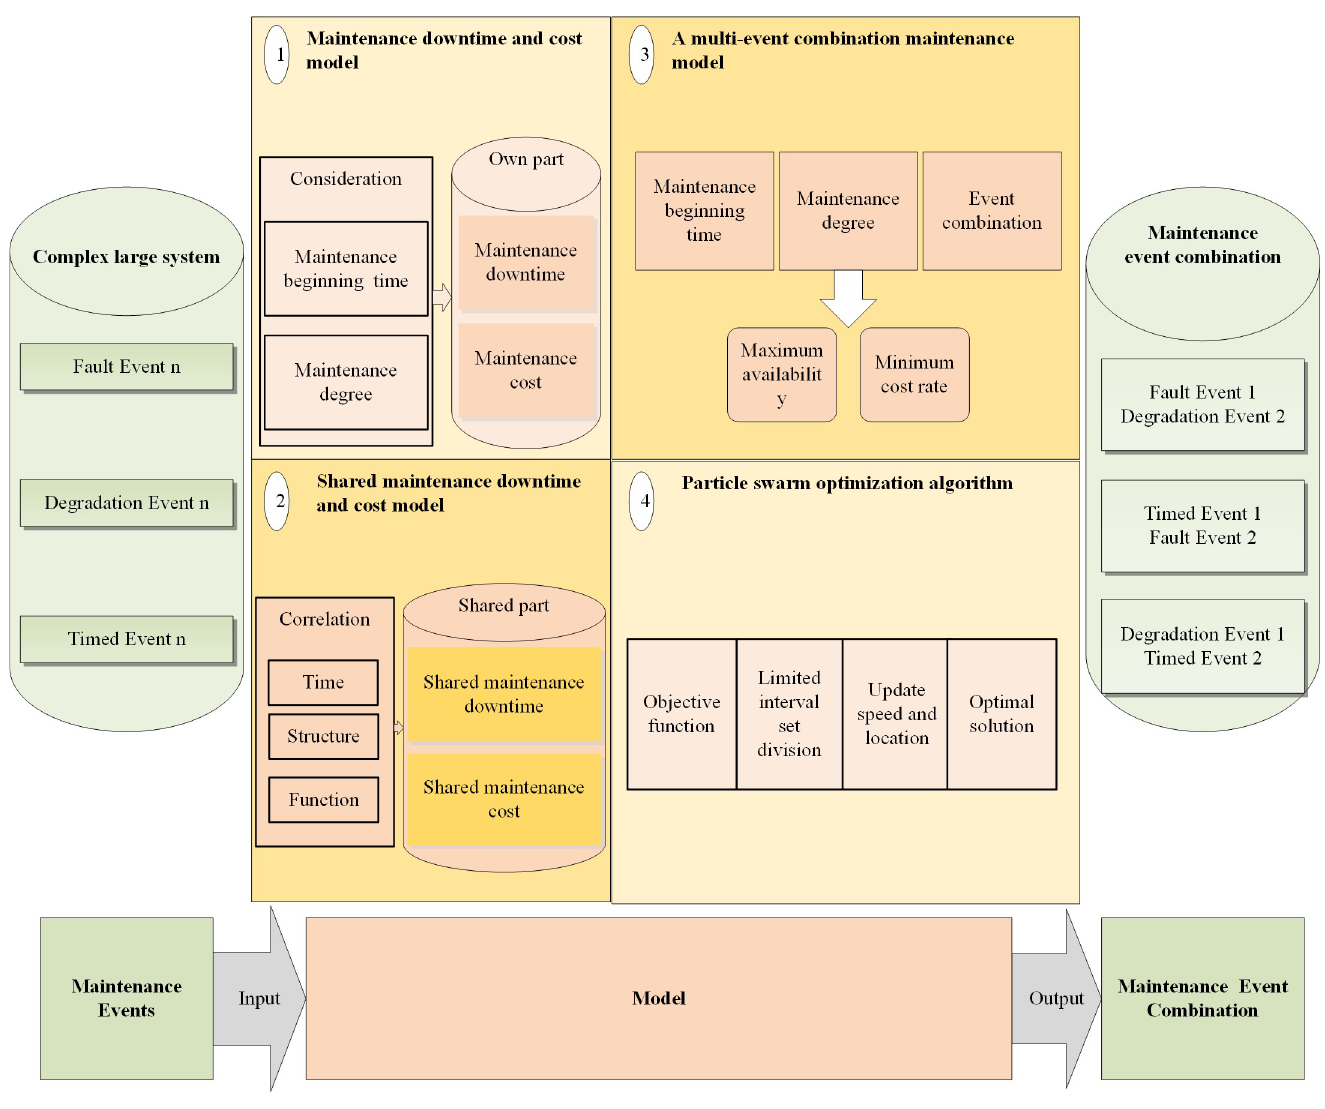
Fig 3. Structure of model